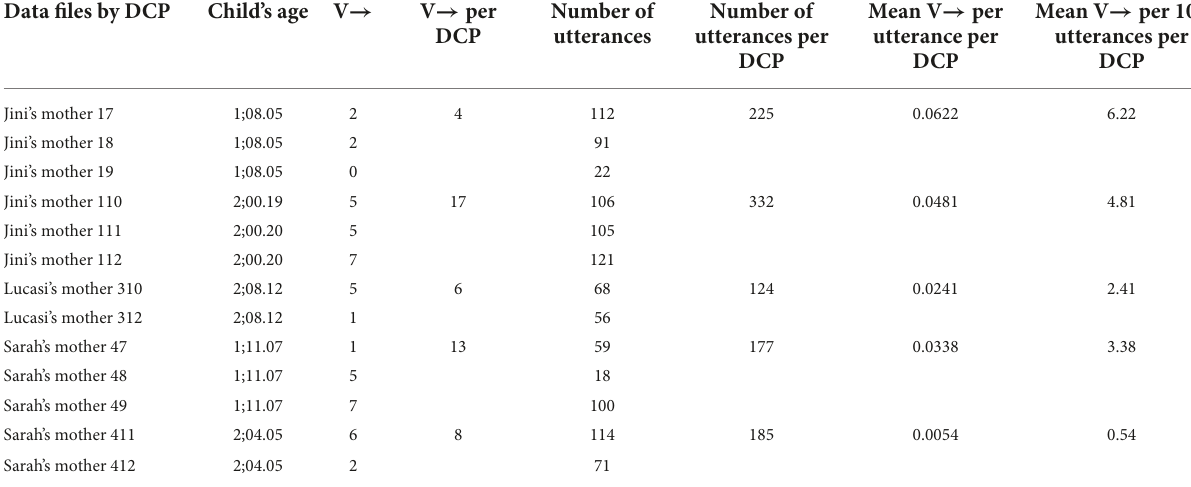
TABLE 3 The number of structures that start as a verb (V → ) and change its class within a word in CDS in Stage 2, per data collection point (DCP). Data files by